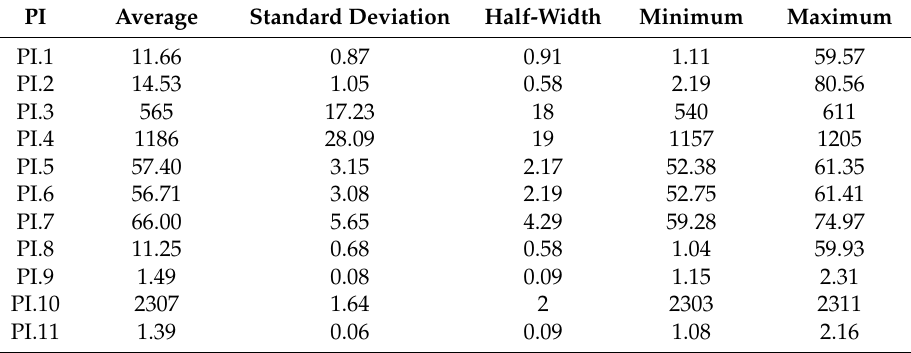
Table 6. Statistical results of each performance indicator when customers exponentially arrive.